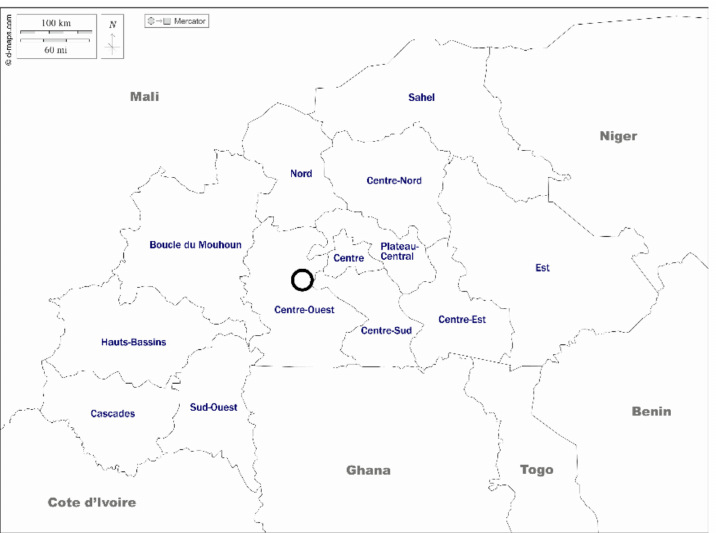
Figure 1. Study site location (circle) in the village of Villy, Central West region, Republic of Burkina Faso [24].